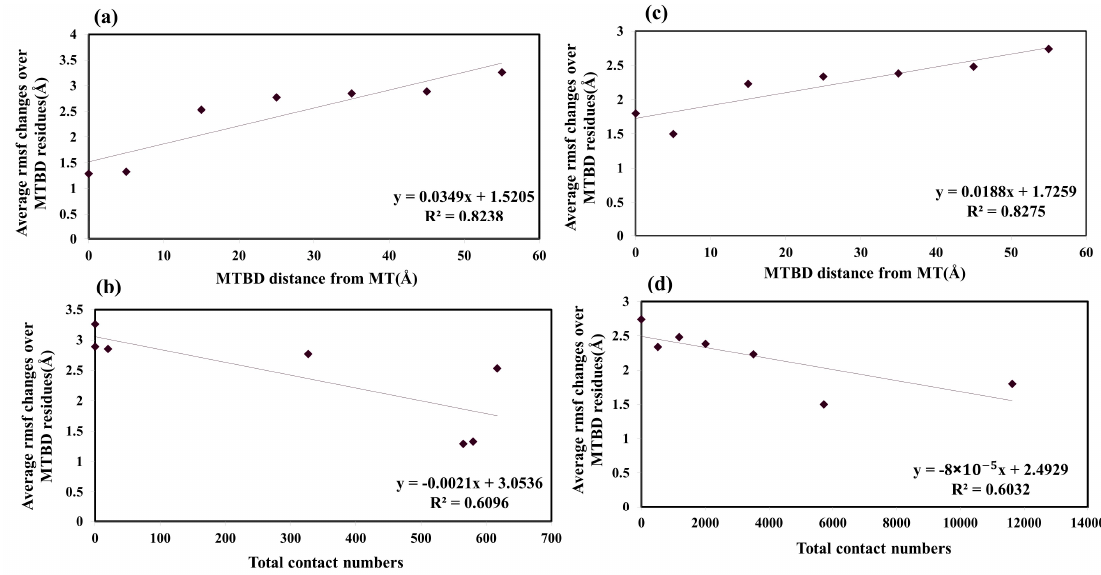
Figure 8. The RMSF changes vs. MTBD distance are shown in panel ( a ) and ( c ) for cytoplasmic and axonemal MTBDs, respectively. The RMSF changes vs. total contact numbers for the MTBD in each distance are shown in panel ( b ) and ( d ) for cytoplasmic and axonemal MTBDs, respectively.